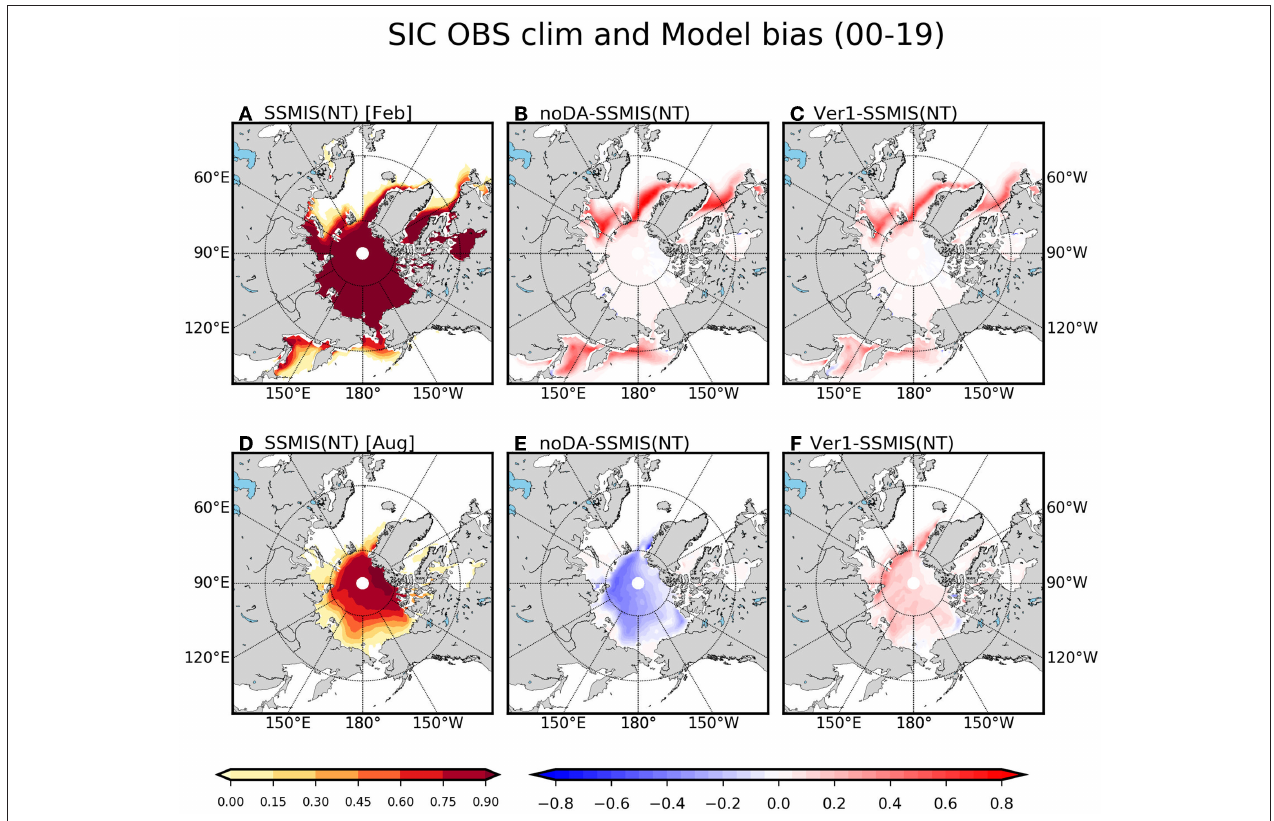
FIGURE 6 | The climatology of sea ice concentration (a fraction from 0 to 1) of SSMIS NT satellite data (A,D) and climatological bias in noDA (B,E) and in Ver1 (C,F) with respect to the satellite observation in February (A–C) and August (D–F) during